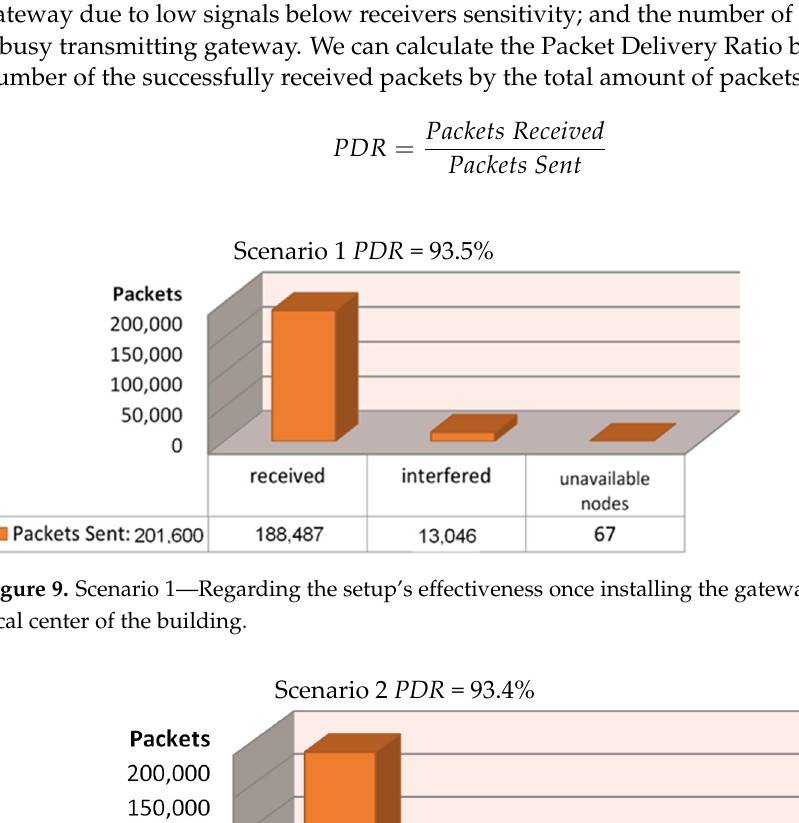
Figure 11. Scenario 3—Regarding the setup’s effectiveness once installing the gateway at the roof of a neighboring building.